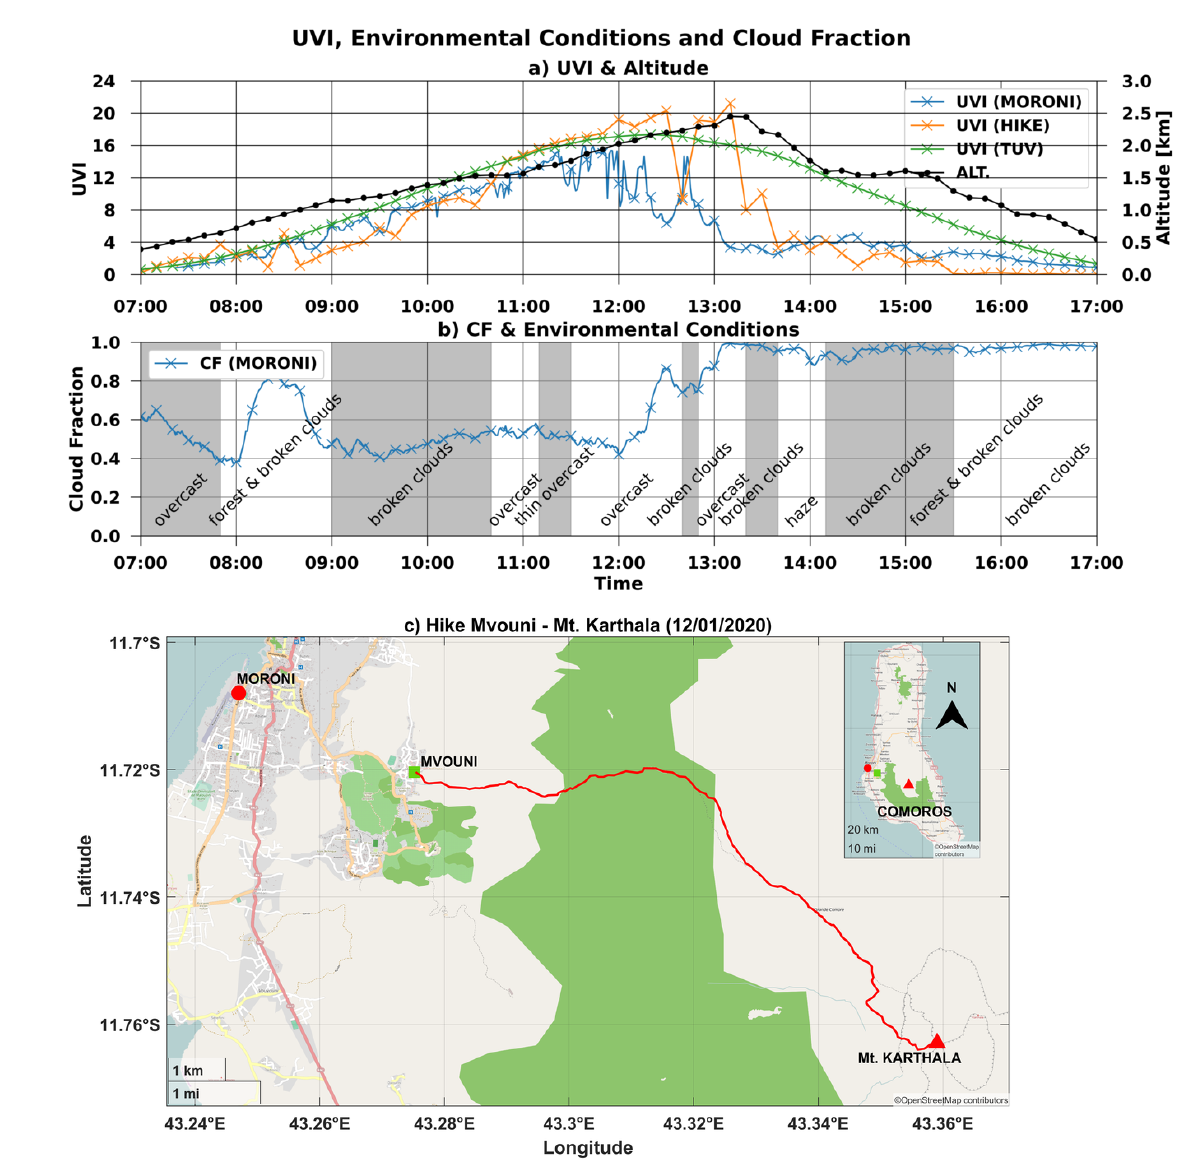
Figure 6. ( a ) UVI, ( b ) cloud fraction, and environmental observations during the hike of 12 January 2020. ( c ) Map showing location of town of Moroni, village of Mvouni, and summit of Karthala, with route taken for hike. Standard erythemal doses (SEDs) and cumulative standard erythemal doses (CSEDs) for the day were also calculated in this study. SED and cumulative SED are shown in Figure 7. To compute SED, the erythemal irradiance is accumulated over a one-minute window. In the first panel (Figure 7a), the diurnal cycle of the SED is shown for the day of 12 January 2020, i.e., during the ascent of Mount Karthala. The SED calculated from UVI- RADIO, located in Moroni, is represented by a blue line, SED calculated from UVI-HIKE is an orange line. On the second panel (Figure 7b), the cumulative SED during the day is shown in blue for Moroni and in orange for the hike. The tolerance thresholds defined by the Fitzpatrick scale [52] are also shown for the two extreme phototypes (I and VI). In the last panel (Figure 7c), the cumulative SED over the day (C-SED) is represented for the whole study period calculated from UVI-RADIO and UVI-TUV-CS. The tolerance thresholds are also plotted on this figure. The SEDs observed in Moroni and on Mount Karthala are